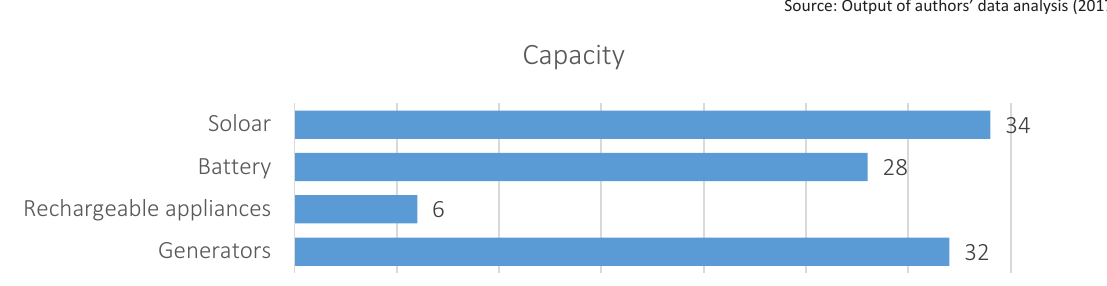
Figure 5. Ratings on